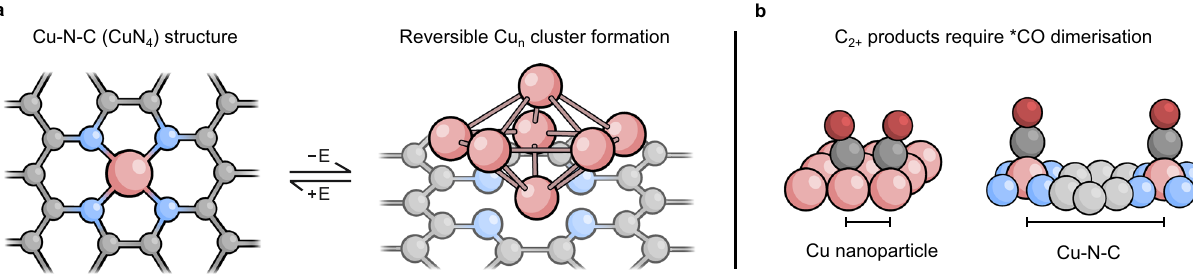
Fig. 1 Reversible agglomeration and CO dimerisation mechanism. a Schematic showing the formation of Cu n clusters under applied cathodic potential ( − E) and the reversibility under oxidative potentials. b Illustration of how Cu – Cu distances in Cu-N-C materials are not compatible with *CO